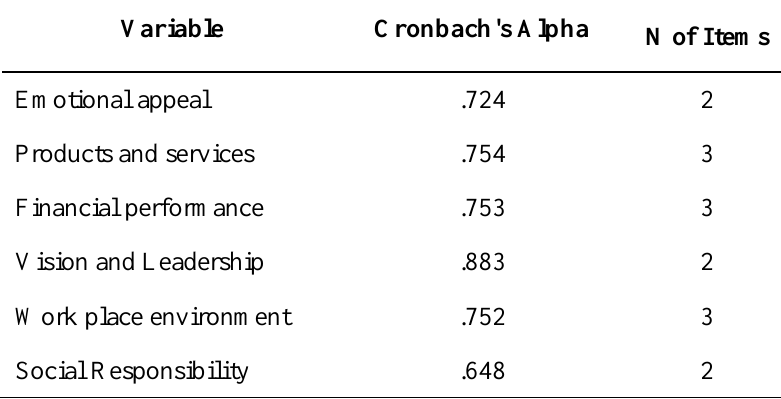
Table 03: Measures of Reliability